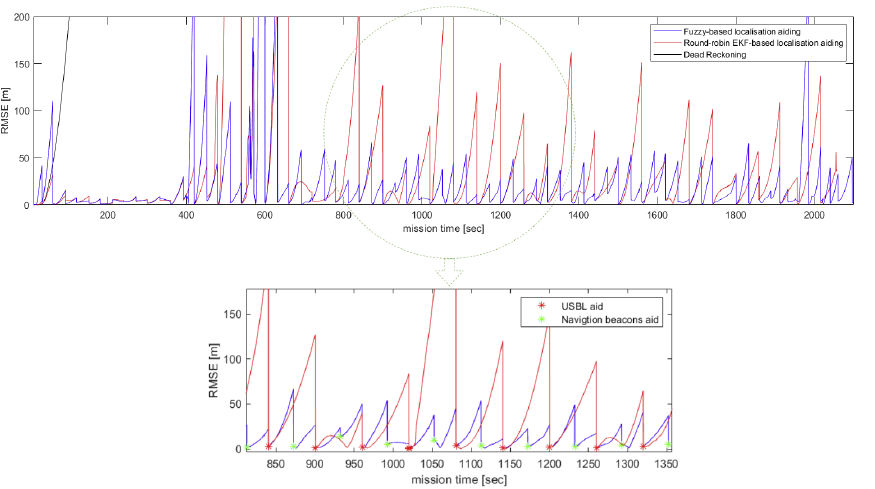
Figure 16. Instantaneous localisation performance of an AUV in a swarm of 150 when the proposed fuzzy-based, round-robin EKF-based and DR-only methods are adopted. A time window of 500 s shows the fused external navigation